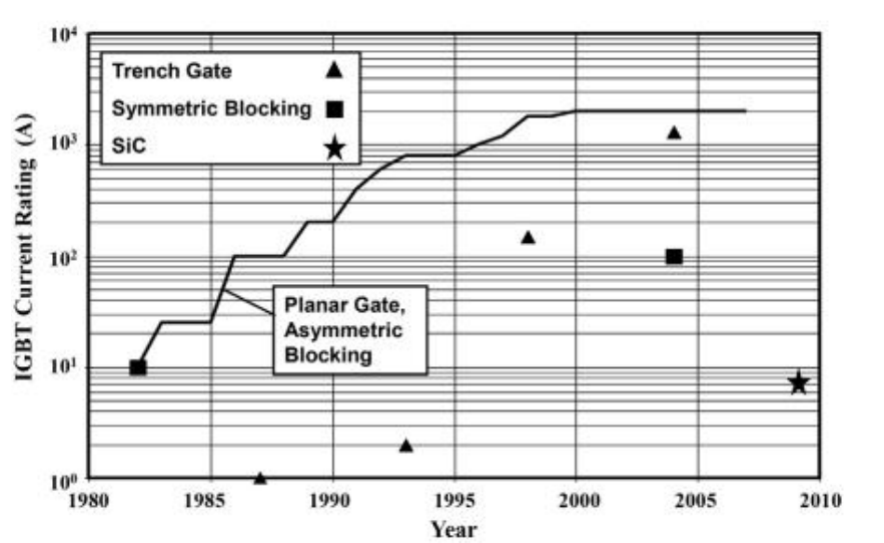
Figure 8. A detailed structure of an IGBT module.